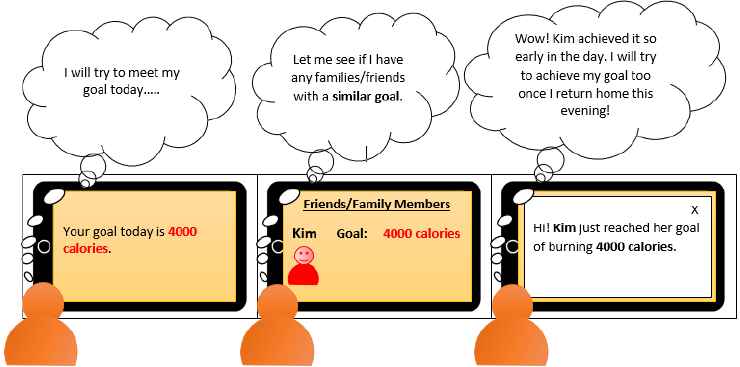
Figure 1. Storyboard illustrating a social learning persuasive feature [17].